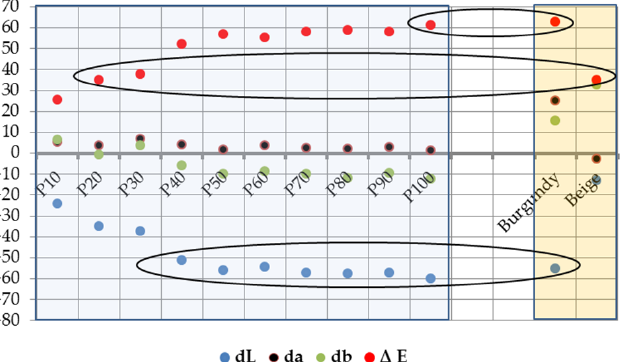
Figure 7. Comparison between colors depending on the power of the laser beam, using CIELab three-dimensional colorimetric system analysis.